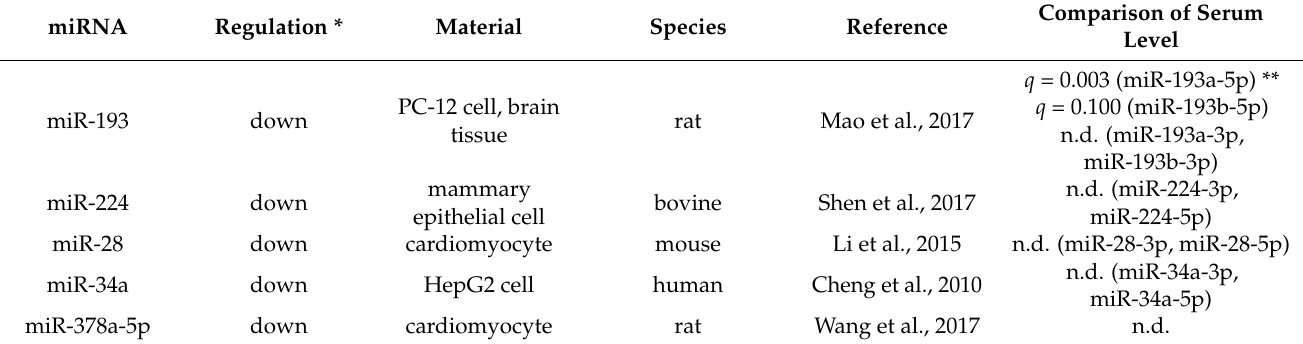
Table 1. ALDH2-related miRNAs and comparison of their serum levels in Austrian and Japanese men. miRNA Regulation